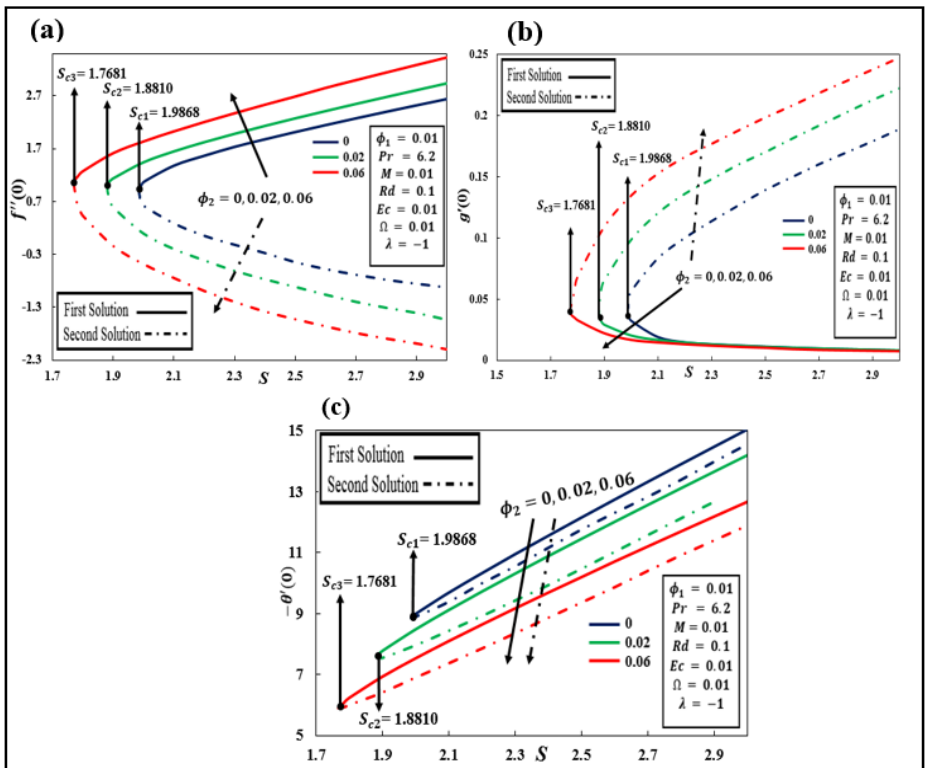
Figure 2. ( a − c ): Influence of 𝜙 (cid:2870) (𝐶𝑢) against suction (𝑆) on 𝑓′′(0) , 𝑔′(0) , and −𝜃′(0) . Figure 2. ( a – c ): Influence of φ 2 ( Cu ) against suction ( S ) on f (cid:48)(cid:48) ( 0 ) , g (cid:48) ( 0 ) , and − θ (cid:48) ( 0 ) . Nanomaterials 2022 , 12 , x FOR PEER REVIEW Due to the existence of multiple solutions, we investigated which of the governing parameters can play a role in the formation of dual solutions. Against varying values of solid nanoparticles, Figure 3a–c demonstrates volume fraction 𝜙 (cid:2870) = 0.0,0.03,and 0.06 along with reduced skin friction 𝑓”(0) and 𝑔′(0) and reduced heat transfer rate −𝜃′(0) through the presence of parameters 𝜙 (cid:2869) = 0.01, 𝑃𝑟 = 6.2, 𝑀 = 0.01,𝑅 𝑑 = 0.1, 𝐸𝑐 = 0.01,Ω = 0.01, and 𝑆 = 2.2 . For shrinking sheet λ ≤ −1 , we can understand that the pres- ence of non-unique solutions is notable. When 𝑖 = 1,2,3 , 𝜆 (cid:3030)(cid:3036) represents the critical point at which both solutions meet at the shrinking sheet parameter. It can be shown that no solution exists when 𝜆 < 𝜆 (cid:3030)(cid:3036) but a unique solution is observed when 𝜆 > −1 . Beyond these critical values, the boundary layer estimate is no longer defensible. Furthermore, the values of 𝜆 (cid:3030)(cid:2869) = −1.2019 , 𝜆 (cid:3030)(cid:2870) = −1.4011 , and 𝜆 (cid:3030)(cid:2871) = −1.5601 are the corresponding criti- cal points of 𝜙 (cid:2870) = 0.0,0.03, and 0.06, respectively. This is proof that increasing the value of 𝜙 (cid:2870) can cause the boundary layer separation to be delayed. Figure 3a shows that in the first solution, the value of 𝑓′′(0) increases when λ ≤ 0 and decreases when λ > 0 , while the second solution declines after the increment of 𝜙 (cid:2870) . In Figure 3b, when the influence of 𝜙 (cid:2870) improves, the value of 𝑔 (cid:4593) (0) decreases in the first and increases in the second so- lution. In Figure 3c, −𝜃′(0) declines in both solutions when 𝜙 (cid:2870) increases. Similar find- ings can be seen in Anuar et al. [22,26].